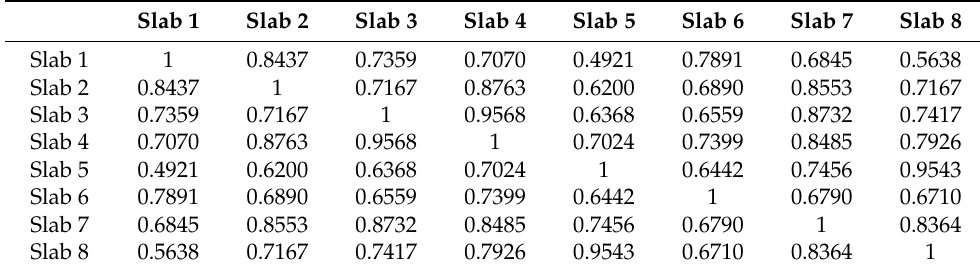
Table 6. Pearson coefficient to evaluate similarity among